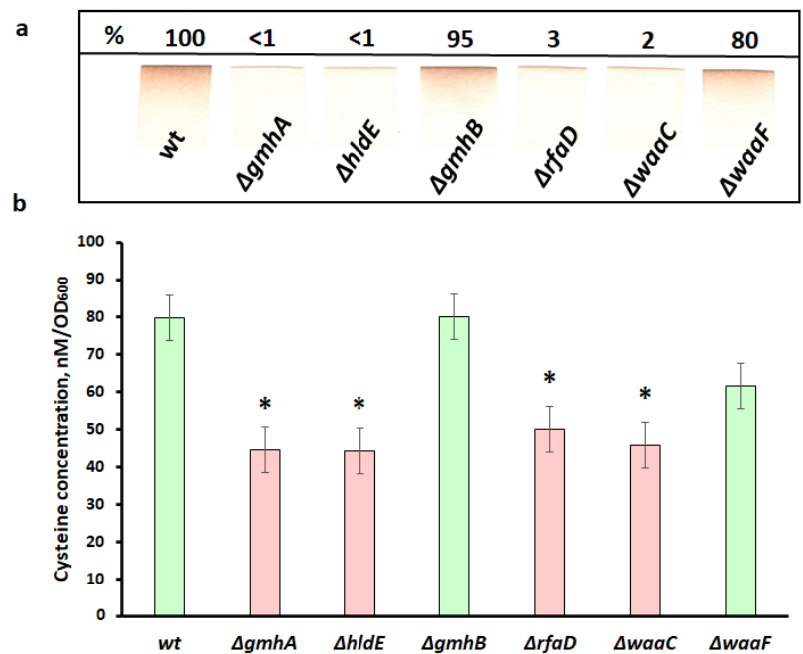
Figure 7. Formation of hydrogen sulfide and intracellular concentration of cysteine in the population of E. coli cells with deletions of the gmhA, hldE, gmhB, rfaD, waaC, waaF genes and wild-type cells. ( a ) Formation of H 2 S by E. coli cells. Pb-acetate-soaked paper strips show a brown colour of PbS as a result of the reaction with gaseous H 2 S exiting liquid bacterial cultures ( b ) Intracellular concentration of cysteine. Parameters for cells with gmhA , hldE , rfaD , and waaC deletions that result in a dramatic increase in antibiotic susceptibility in E. coli cells are shown in red, while parameters for wt , gmhB, and waaF are shown in green. Mean values ± SD from at least three independent experiments are shown. * — p < 0.05, compared to the wild-type cells.